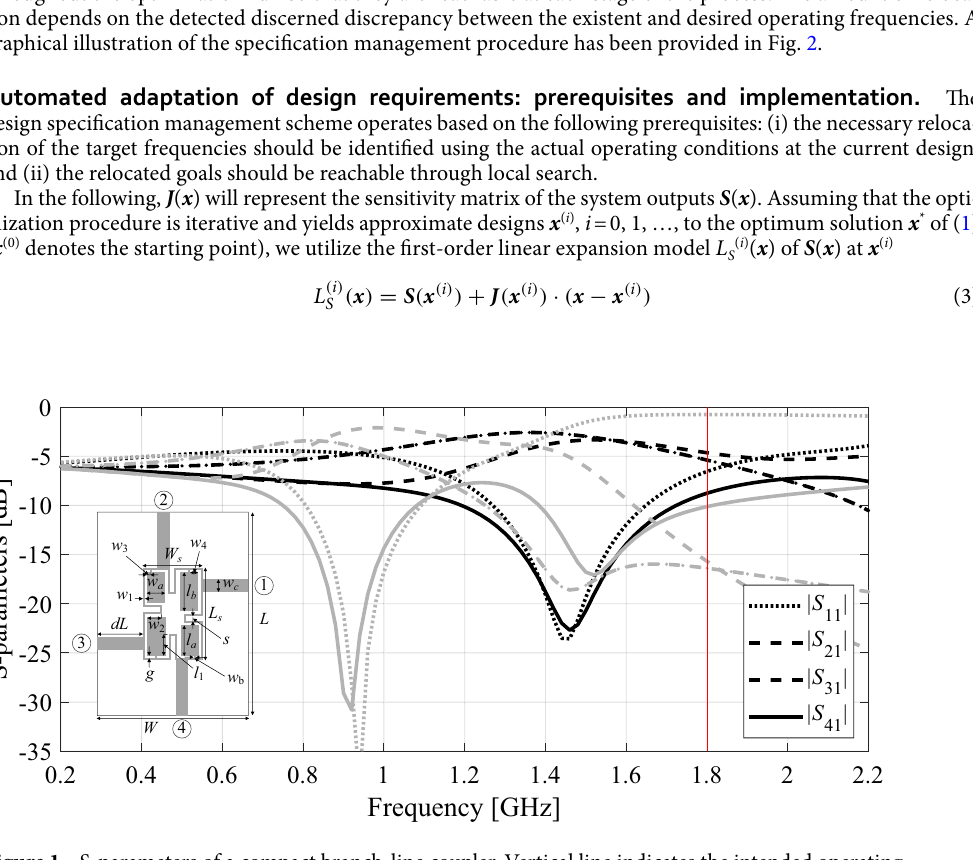
Figure 1. S-parameters of a compact branch-line coupler. Vertical line indicates the intended operating frequency of 1.8 GHz, which is reachable by a local optimizer if launched from the design marked black. Yet, it cannot be reached from the design marked grey due to the operating frequency overly distant from the intended